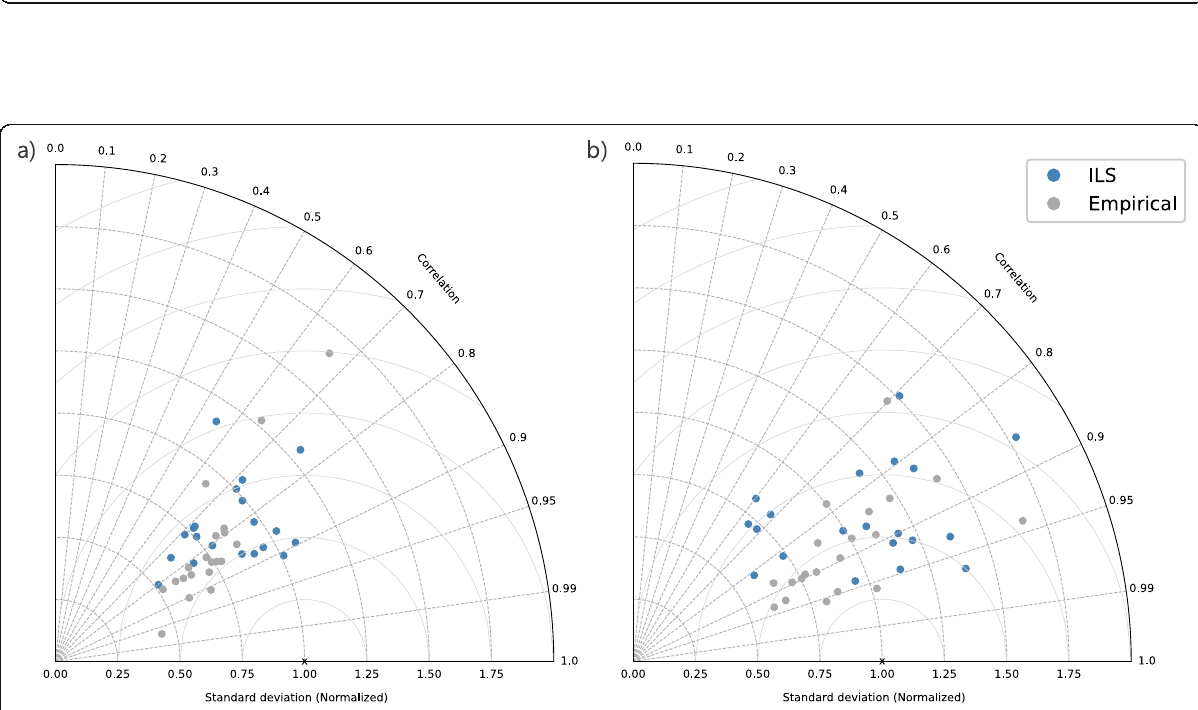
Fig. 10 Taylor diagram for half-hourly a latent and b sensible heat fluxes. Blue shows ILS results and gray shows two-variable regression. Standard deviation and root-mean-square difference are standardized by the standard deviation of